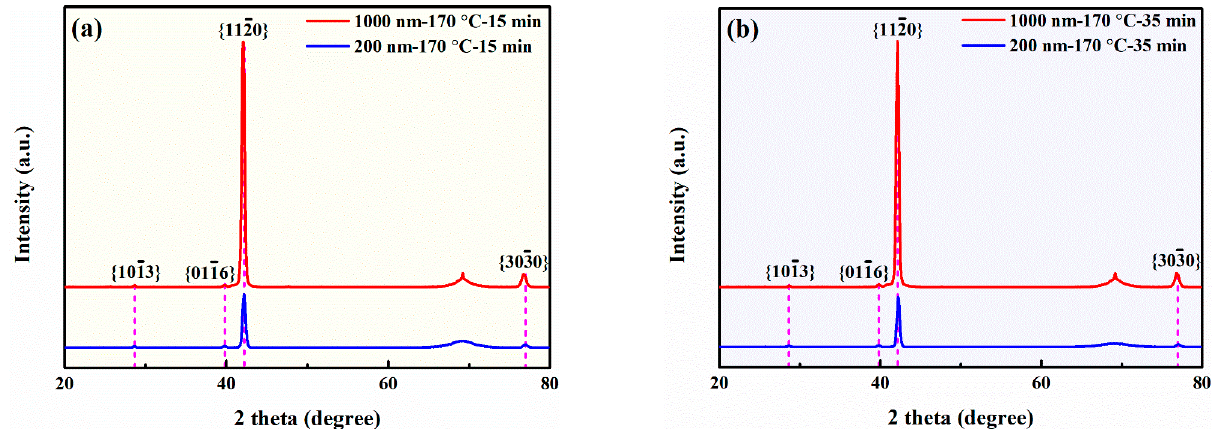
Figure 6. XRD patterns of 200 nm and 1000 nm Sb 2 Te thin films annealed at different times: ( a ) 15 min; ( b ) 35 min. Table 2. Diffraction intensities of (cid:4668)112(cid:3364)0(cid:4669) , (cid:4668)303(cid:3364)0(cid:4669) , (cid:4668)101(cid:3364)3(cid:4669) , and (cid:4668)011(cid:3364)6(cid:4669) planes of 200 nm and 1000 nm Sb 2 Te thin films annealed at 15 min and 35 min (shown in parentheses).